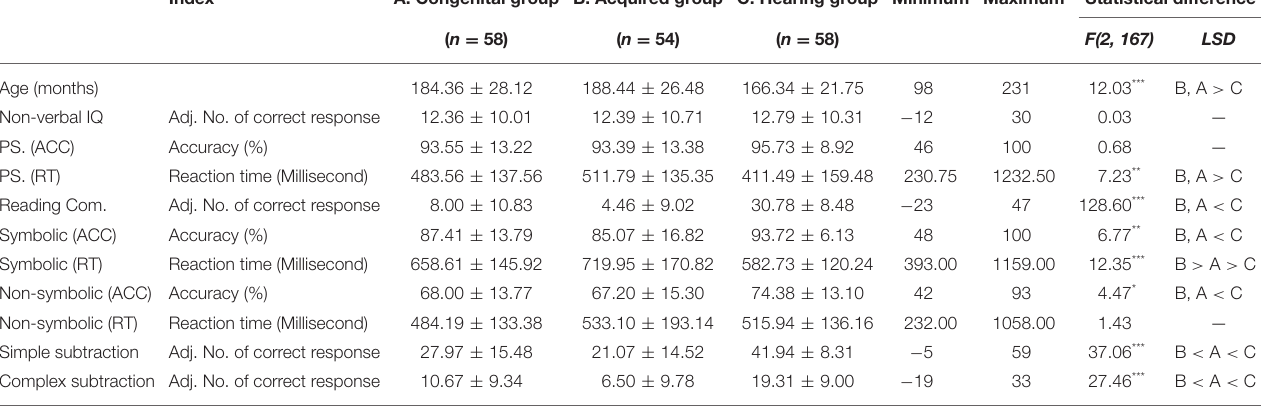
TABLE 1 | All the measures on the study groups (M ± SD).